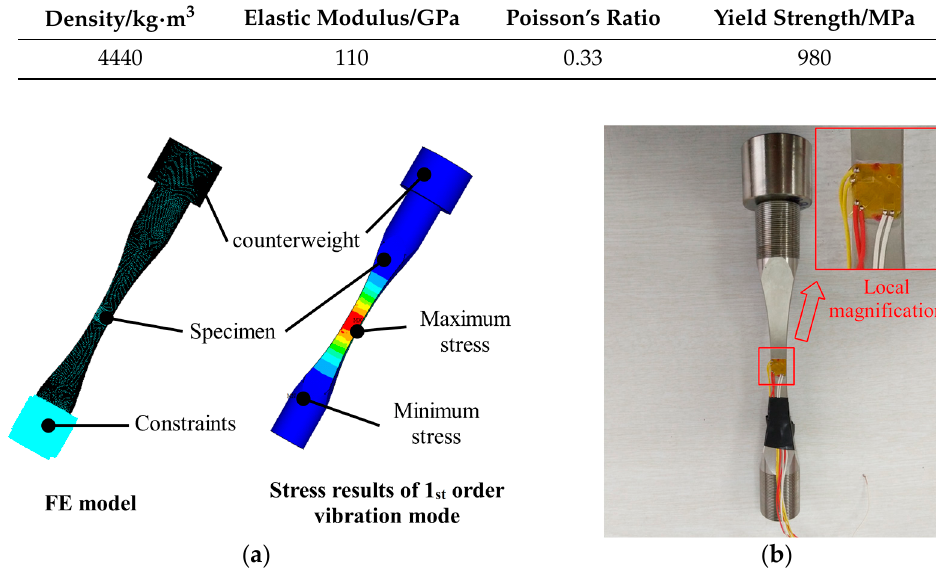
Figure 2. Finite element (FE) modal analysis and sticking position of the strain rosette: ( a ) FE model and first-order vibration mode result; and ( b ) sticking position of the strain rosette.